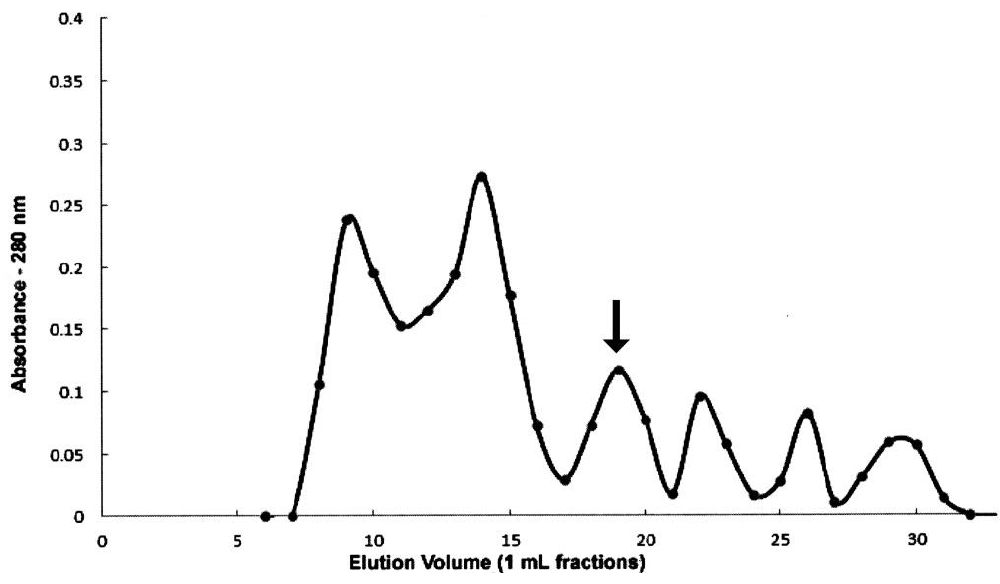
Figure 9. Gel filtration chromatography of the testes extract. Zero point five milliliters sample was applied to a Superose-12 (10/30) column with a bed volume of 23.6 mL. Fractions (1 mL) were collected at ambient temperature. Proteins elute in descending order of molecular weight, proteins of a larger mass elute early and smaller proteins elute